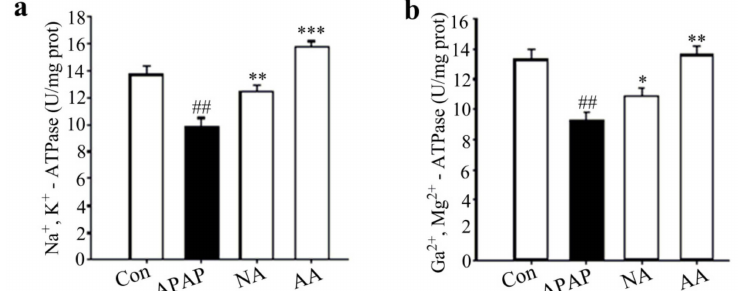
Figure 3. E ff ects of AS pretreatment on mitochondrial Na + , K + -ATPase and Ca 2 + , Mg 2 + -ATPase during APAP-induced hepatotoxicity. The activities of Hepatic Na + , K + -ATPase ( a ) and Hepatic Ca 2 + , Mg 2 + -ATPase ( b ) were expressed in U / mg protein (prot). Data are presented as means ± SD ( n = 10). ## p < 0.01 compared to the Con group; * p < 0.05, ** p < 0.01, *** p < 0.001 compared to the APAP group.